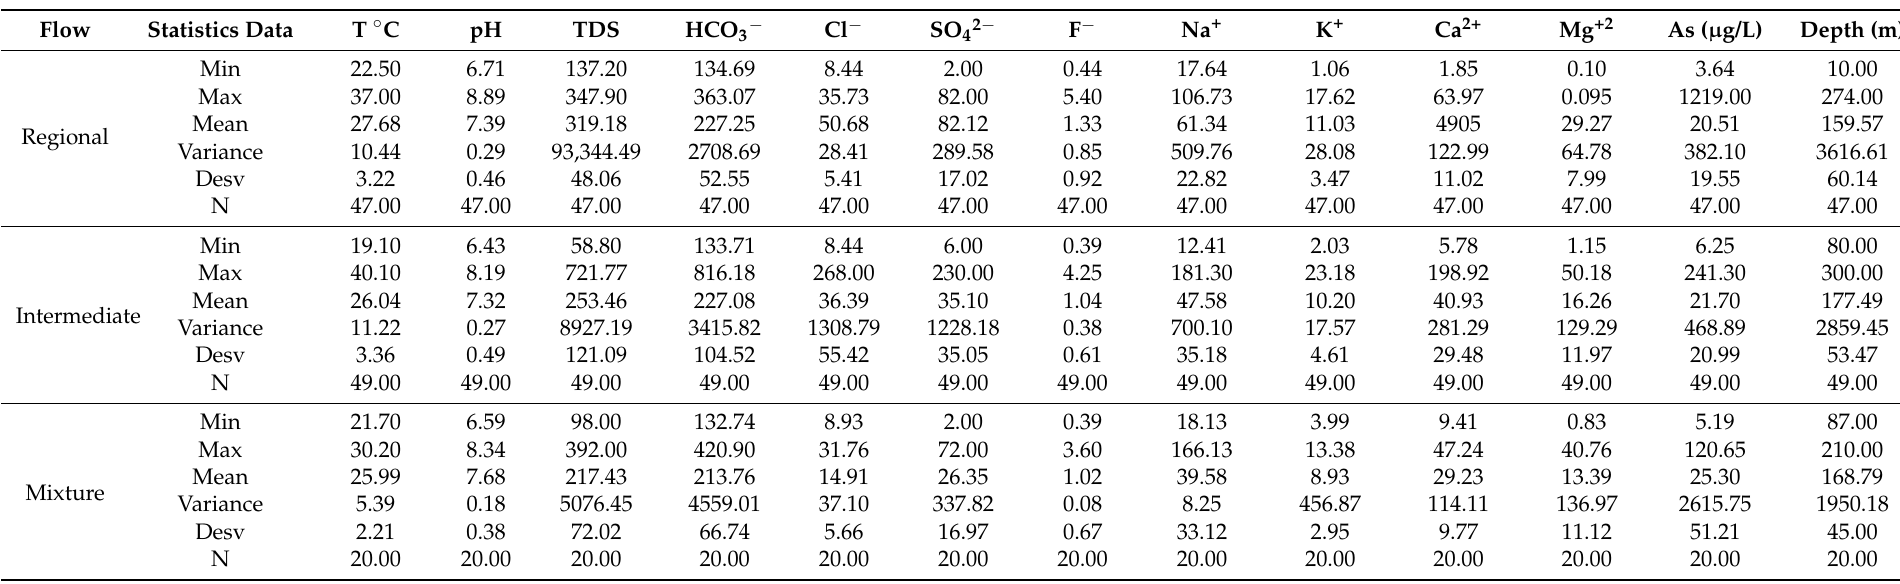
Table 5. Clustering of flows as a result of cluster analysis for the year 2015 (TDS = total dissolved solids, concentration mg/L; modified from Avila et al., 2018).